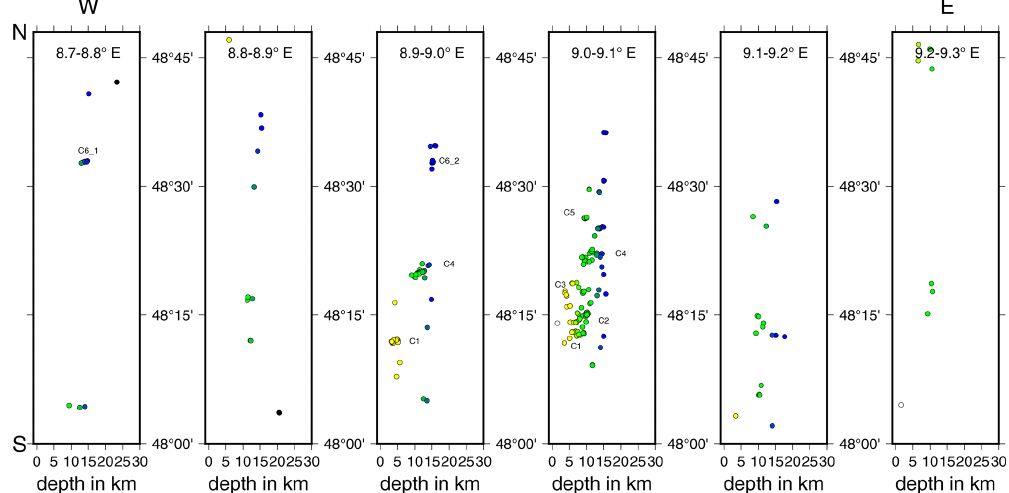
Figure 11. Seismicity distribution of the ASZ from west (left) to east (right). Circles indicate hypocenters in the corresponding slice, color- coded by depth (as in Fig. 7); cluster codes are given for